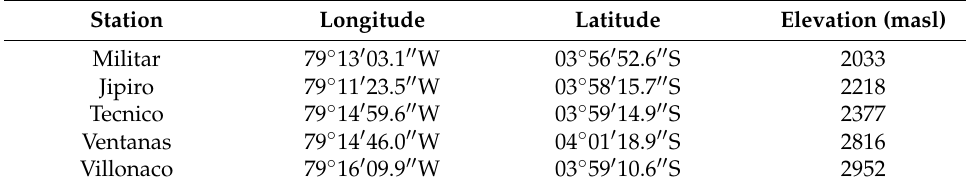
Table 2. Weather stations in the study